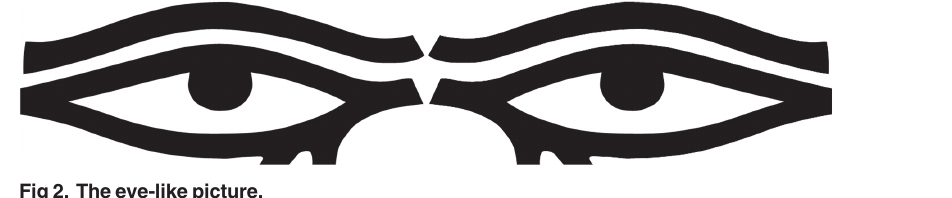
Fig 2. The eye-like